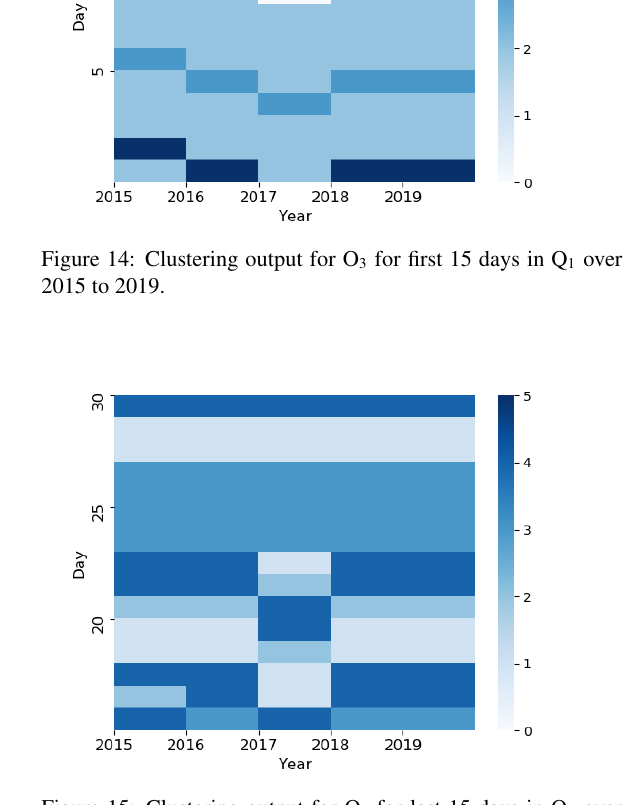
Figure 15: Clustering output for O 3 for last 15 days in Q 1 over 2015 to 2019.